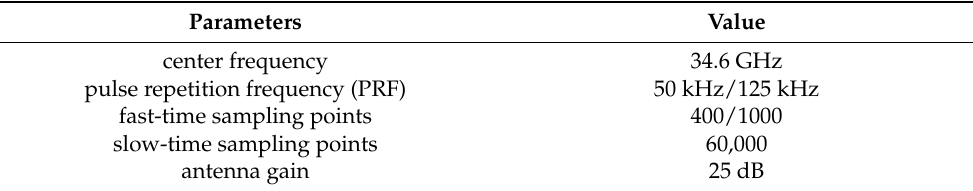
Table 3. Radar parameters.